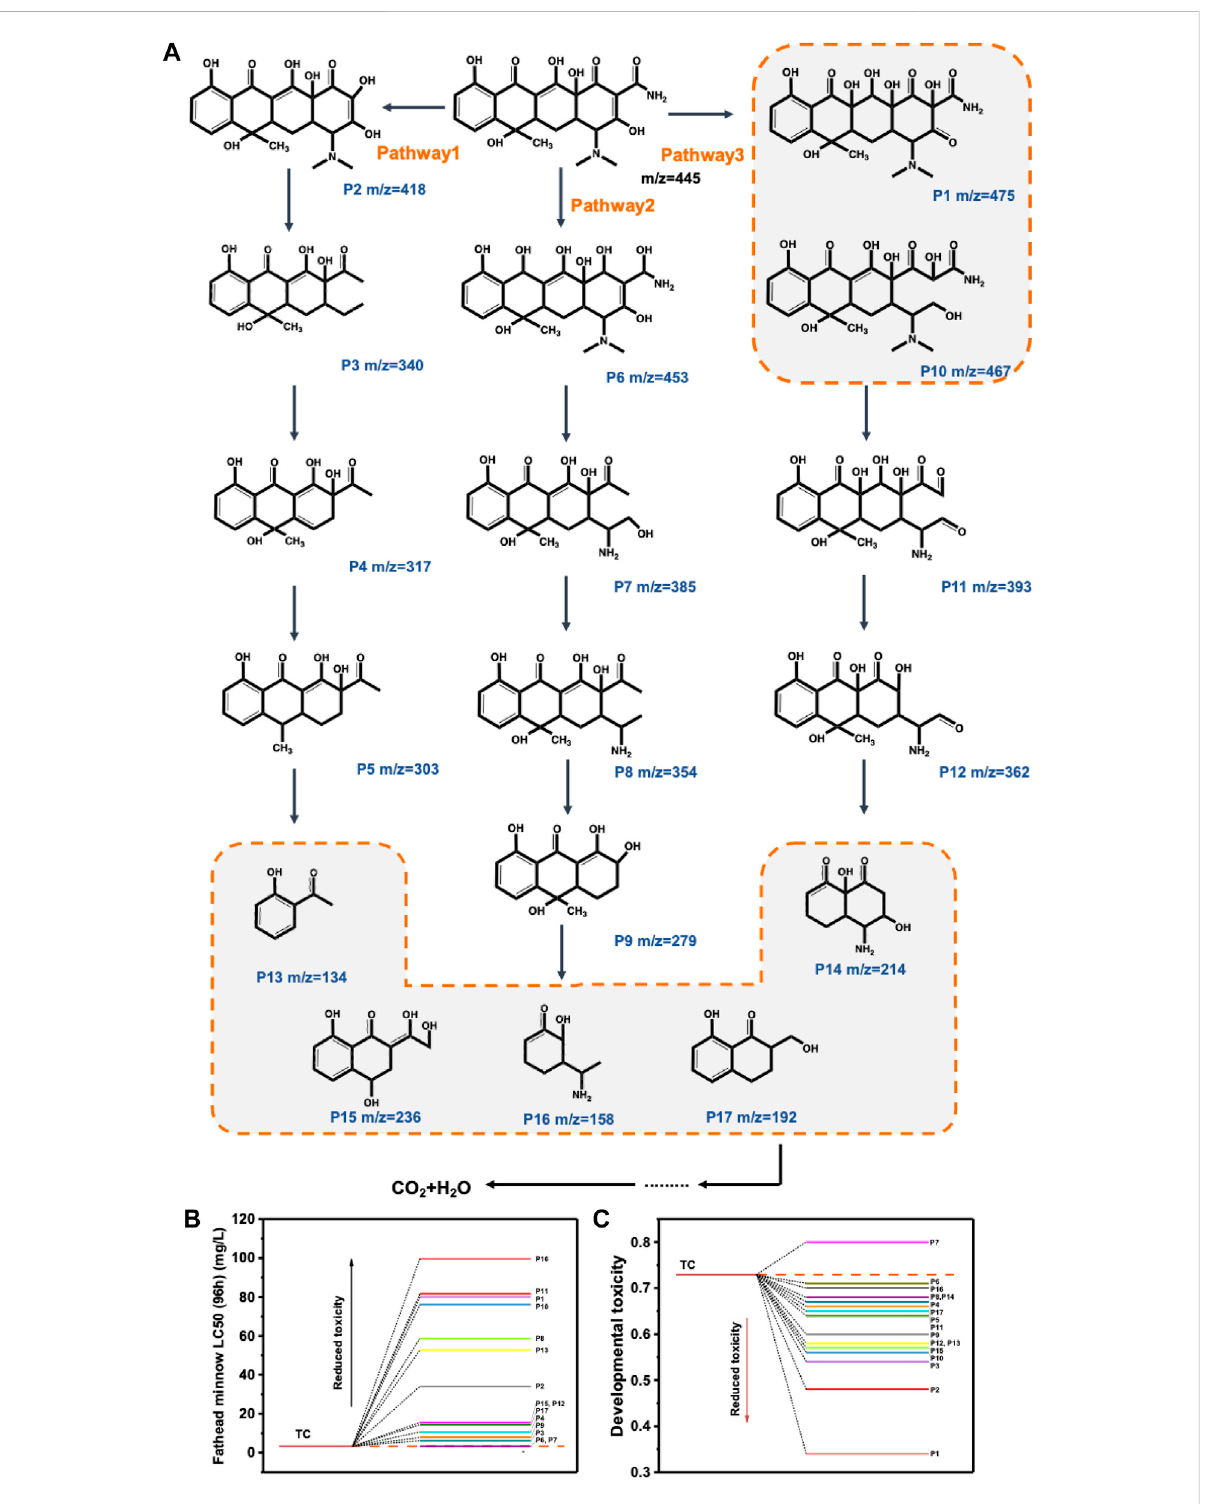
FIGURE 8 The possible TC photocatalytic degradation pathways over SBB-100 (A) ; Evaluation of TC and its degradation intermediates for acute (B) and developmental toxicity (C)